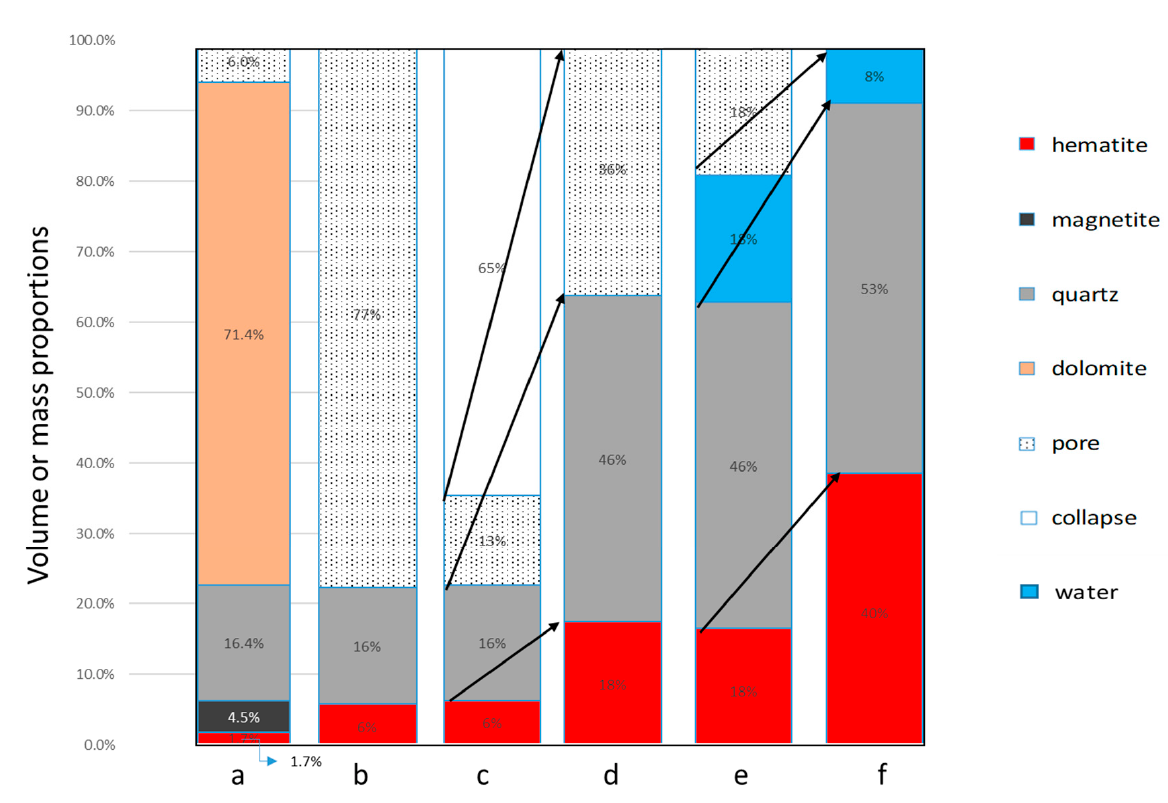
Figure 9. a volume proportion of non-weathered quartz dolomite; b hypothetical void generation after dolomite leaching if collapse is unconsidered; c collapse volume and actual void volume in residual rock volume proportion; d residual volumes of mineral and voids (porous) in weathered rock; e volumes of mineral, wet and dry voids (porous) in weathered rock; f residual mass proportion of minerals and water in weathered rock.